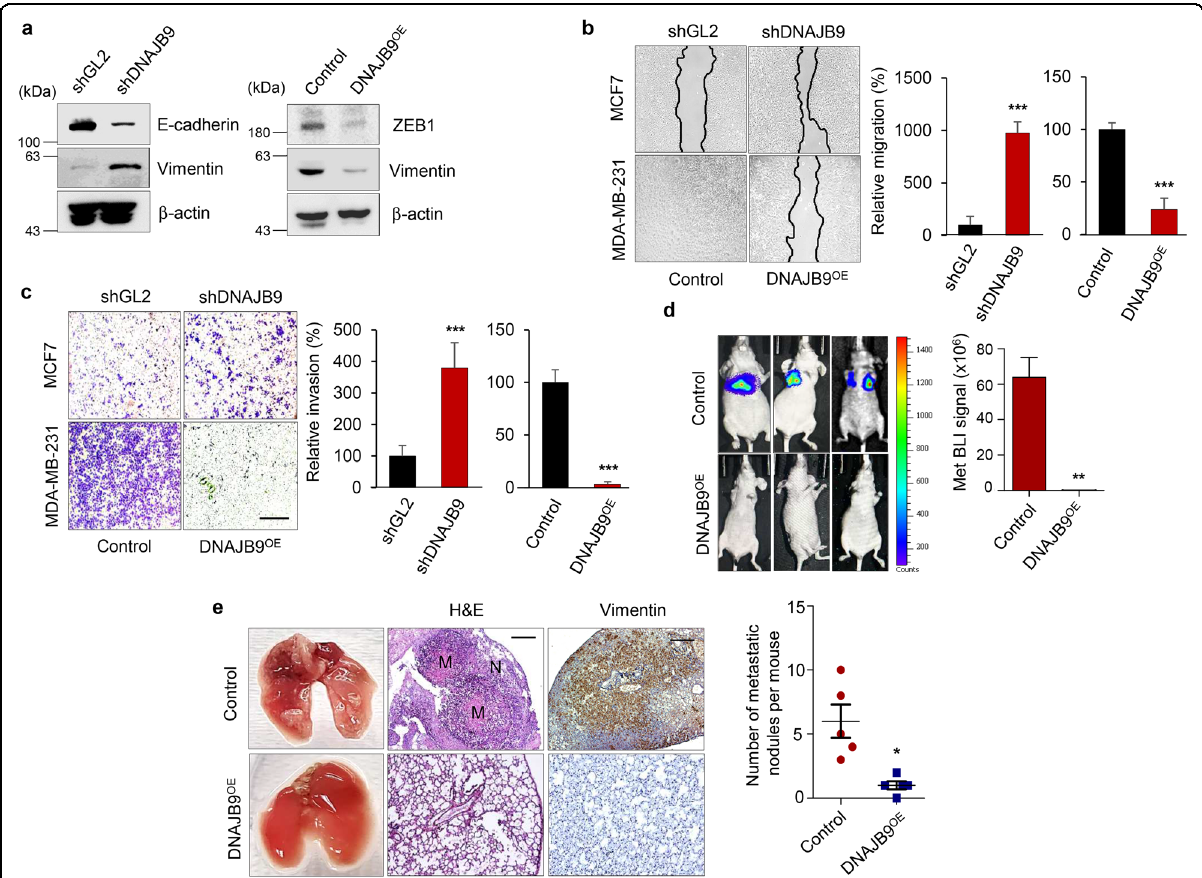
Fig. 2 DNAJB9 suppresses the migration and metastasis of TNBC in vitro and in vivo. a Epithelial – mesenchymal transition markers (ZEB1, E-cadherin, and Vimentin) were validated in MCF7 – shDNAJB9 and MDA-MB-231 – DNAJB9-OE cells using western blotting. β -Actin was used as normalization controls. b , c To measure the metastatic potential of cancer cells, wound healing ( b ) and transwell cell invasion assay ( c ) were performed in MCF7 – shDNAJB9 and MDA-MB-231 – DNAJB9-OE cells. Representative images are shown in the left panel. The quantitative results are shown in the right panel. Scale bar, 500 μ m. d MDA-MB-231 – DNAJB9-OE or control cells (1 × 10 6 ) were intravenously injected into 6-week-old female immunode fi cient mice. The representative bioluminescence images of lung metastasis and the quanti fi cation of the bioluminescence intensity. e Representative images of metastatic lung tumors, hematoxylin and eosin (H&E), and Vimentin are shown. The number of lung tumors derived from MDA-MB-231 – DNAJB9-OE or control cells was quantitatively analyzed. Scale bar, 200 μ m. Results are presented as mean ± standard deviation from three independent experiments. * p < 0.05; ** p < 0.01; *** p <